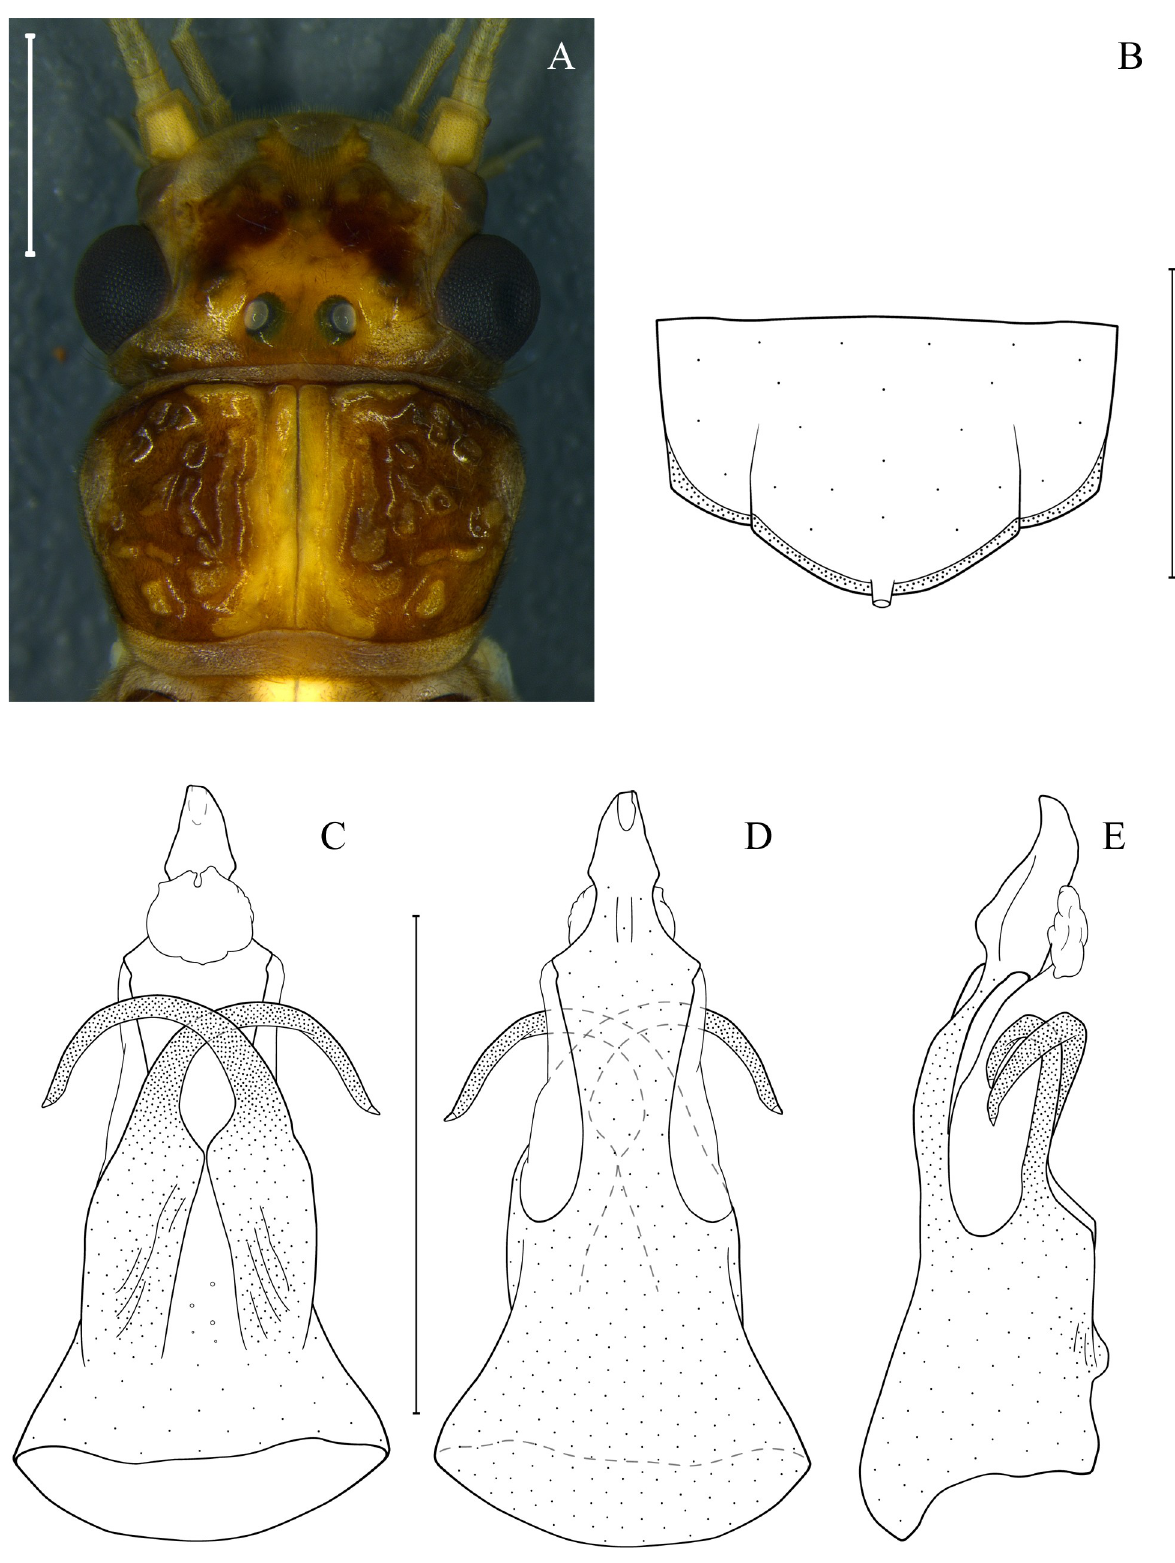
Fig 8. Anacroneuria fiorentini . Teneral male, head and pronotum (A). Tergum 9 with hammer (B). Penial armature in ventral (C), dorsal (D), and lateral (E) views. Scale: 1 mm. https://doi.org/10.1371/journal.pone.0243393.g008 PLOS ONE | https://doi.org/10.1371/journal.pone.0243393 December10,